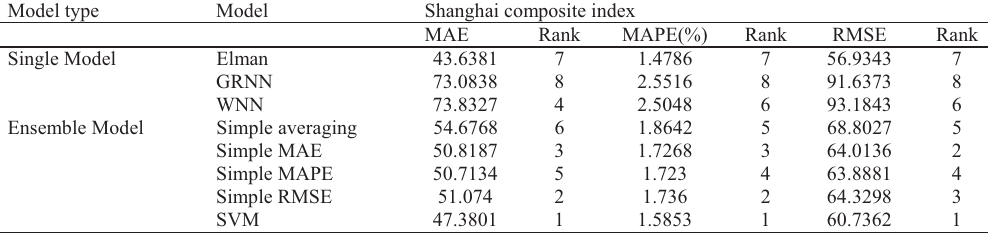
Table 2. Comparison of performance statistics averaging each model over 20 runs in Shanghai composite index.